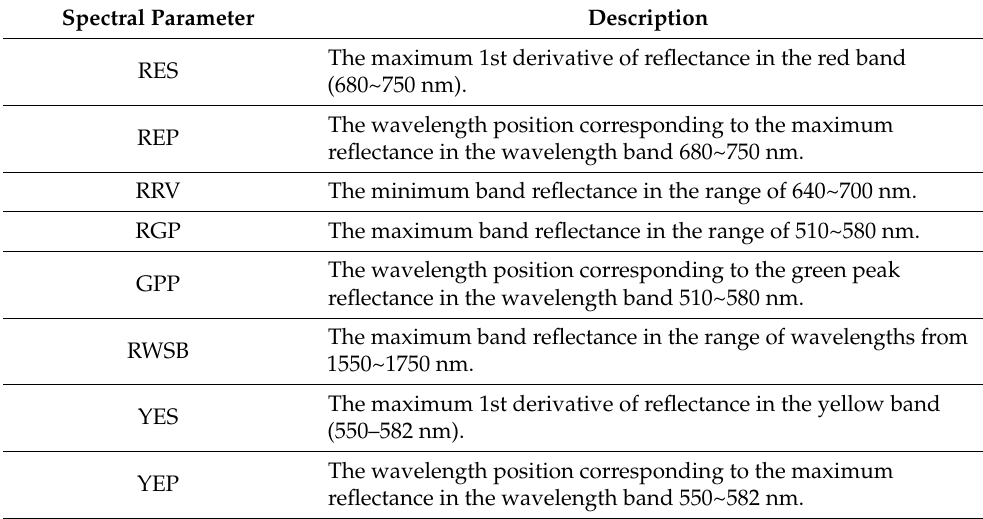
Table 1. Spectral parameters and their